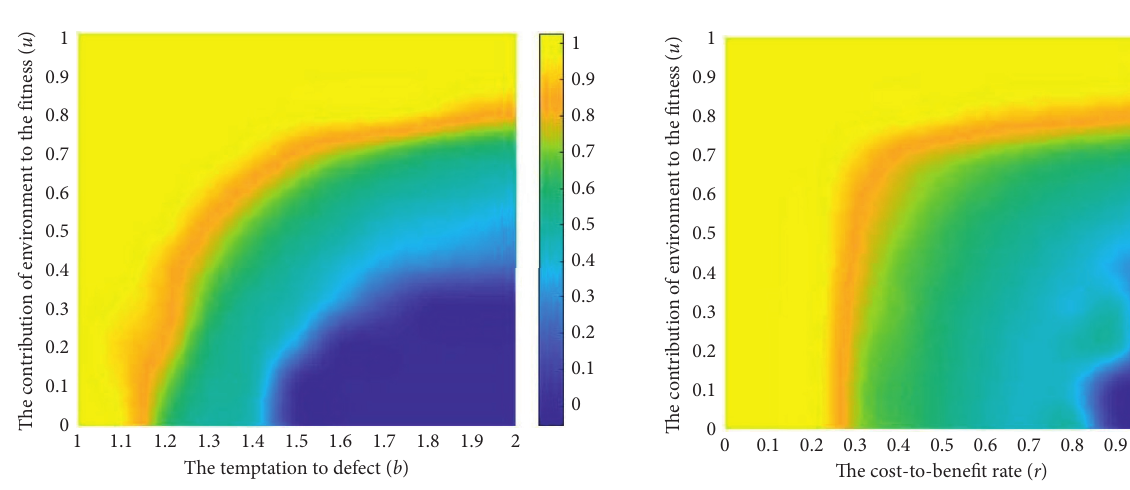
Figure 6: The colour-coded (see the bar on the right) density of cooperation ρ c on the u − r parameter plane. The depicted are obtained in SDG for α � 2. The yellow shading corresponds to the higher stationary density of cooperators at each particular com- bination of u and r . It can be observed that u promotes cooperation better than the r